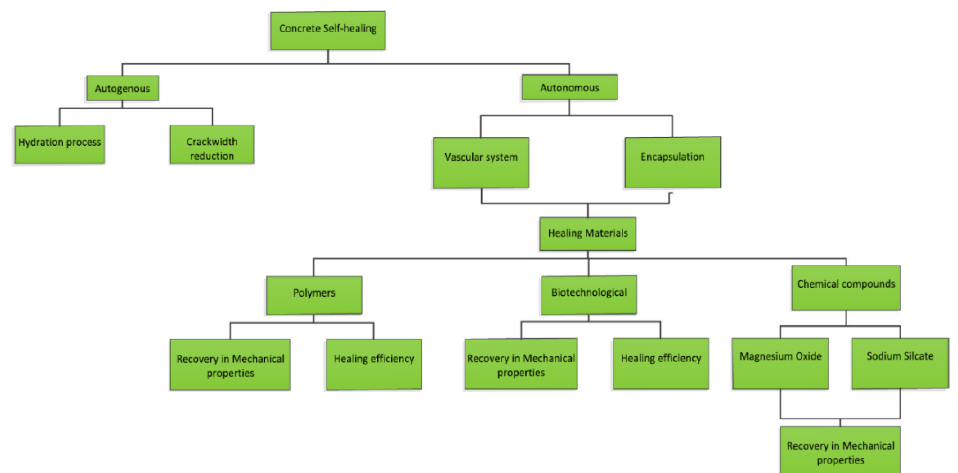
Figure 1. Different types of self-healing in concrete [12].